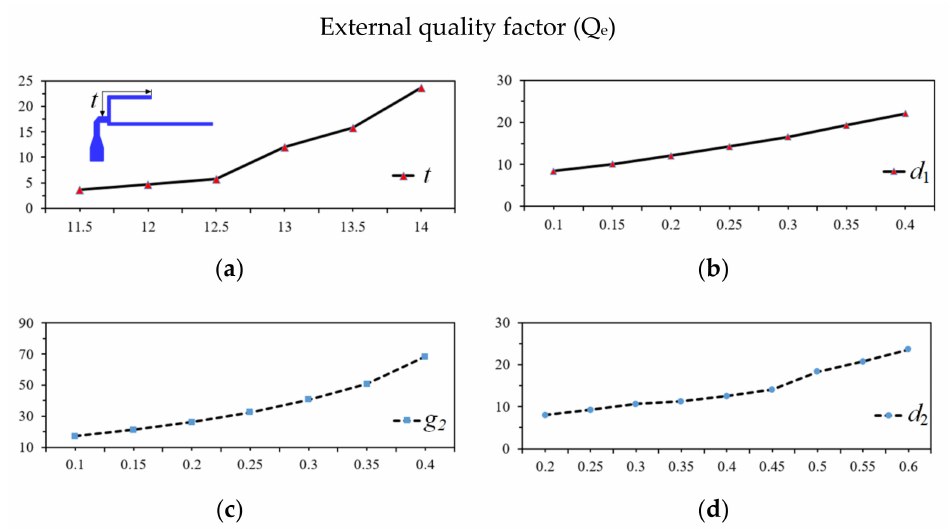
Figure 6. External quality factor with variation of t , g 2 , d 1 , and d 2 . ( a ) The tapped line position t (mm). ( b ) Coupling space d 1 (mm). ( c ) Coupling space g 2 (mm). ( d ) Coupling space d 2 (mm). The third step is to design the open-circuit dual-mode SLR for the fourth